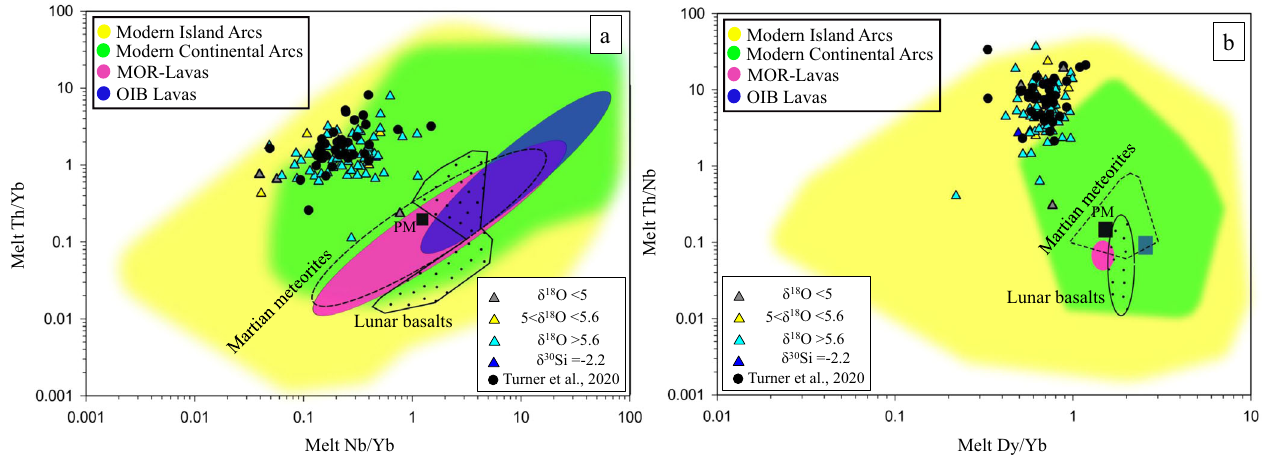
Fig.4|ComparisonofelementalratiosofderivedmeltvaluesbetweenourJHZs (Jack HillsZircons;red, yellow, cyan, andbluetriangles)and thosereportedin ref. 6 (black circles) to modern lavas. a Th-Nb proxy used to classify lavas from differentregimes,wherelunarandMartiansamplesareshownaspossiblestagnant- lid analogues 62 . Field legend: OIB lavas(Ocean Island Basalt; Blue),MORlavas(Mid Oceanic Ridge; Red), Modern arc lavas (Green/Yellow). Data sources: MOR+OIB Lavas 32 ; Arc lavas compiled from the GEOROC database (Island arcs: Aleutian